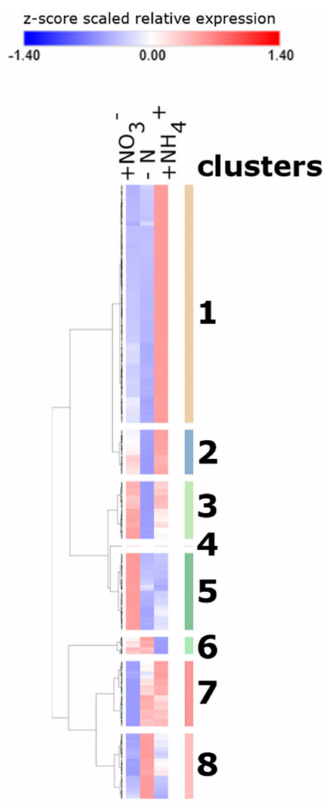
Figure 2. Clustering analysis of genes di ff erentially expressed in + NO3- and + NH4 + treatments with respect to the control (-N) in maize root tissues. z-score scaled RPKM values for all the 2324 genes resulted as DEGs in at least one treatment were used for hierarchical clustering analysis. The analysis reveals eight di ff erent clusters with specific expression behaviors in response to di ff erent N-provision or deficiency. Re-scaled expression values for each gene in each sample are reported in a blue to red color scale (blue: lower RPKM values, red: higher RPKM values). RPKM: Reads Per Kb per